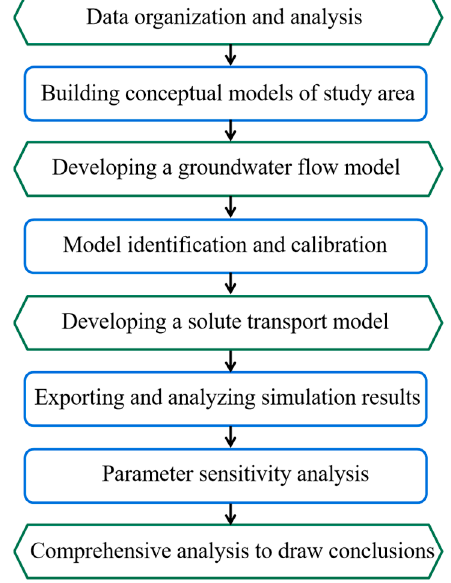
Figure 3. Work fl ow chart for numerical simulation research